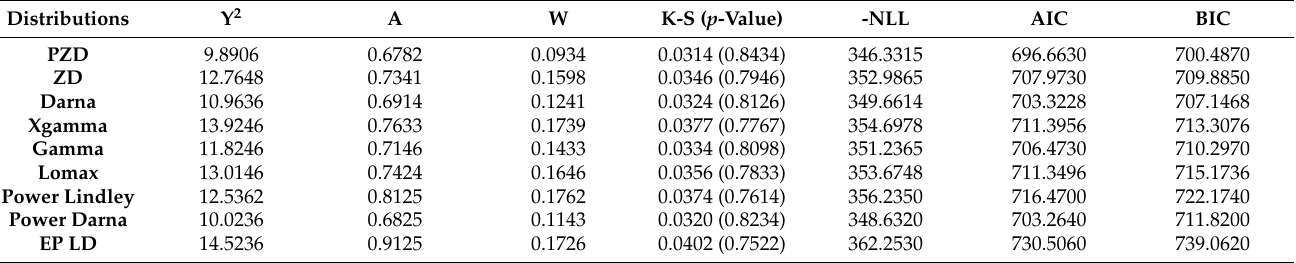
Table 8. ML parameter estimates for the alternative distributions based on cancer patients’ data. Table 9. Values of criteria statistics for model selection based on cancer patients’